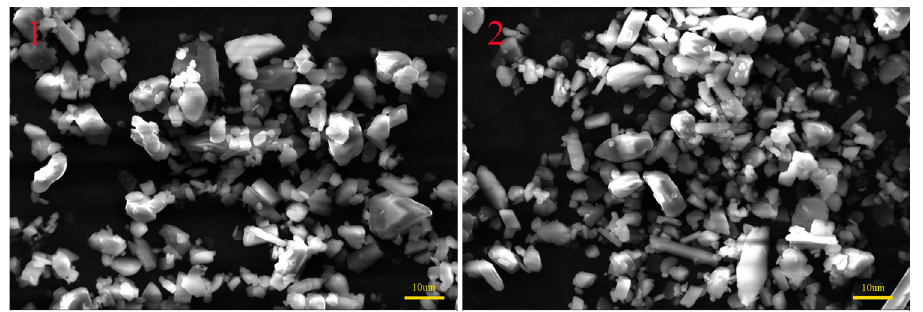
Figure 5: Micrographs of battery - grade Li 2 CO 3 - 1 and Li 2 CO 3 - 2 products.